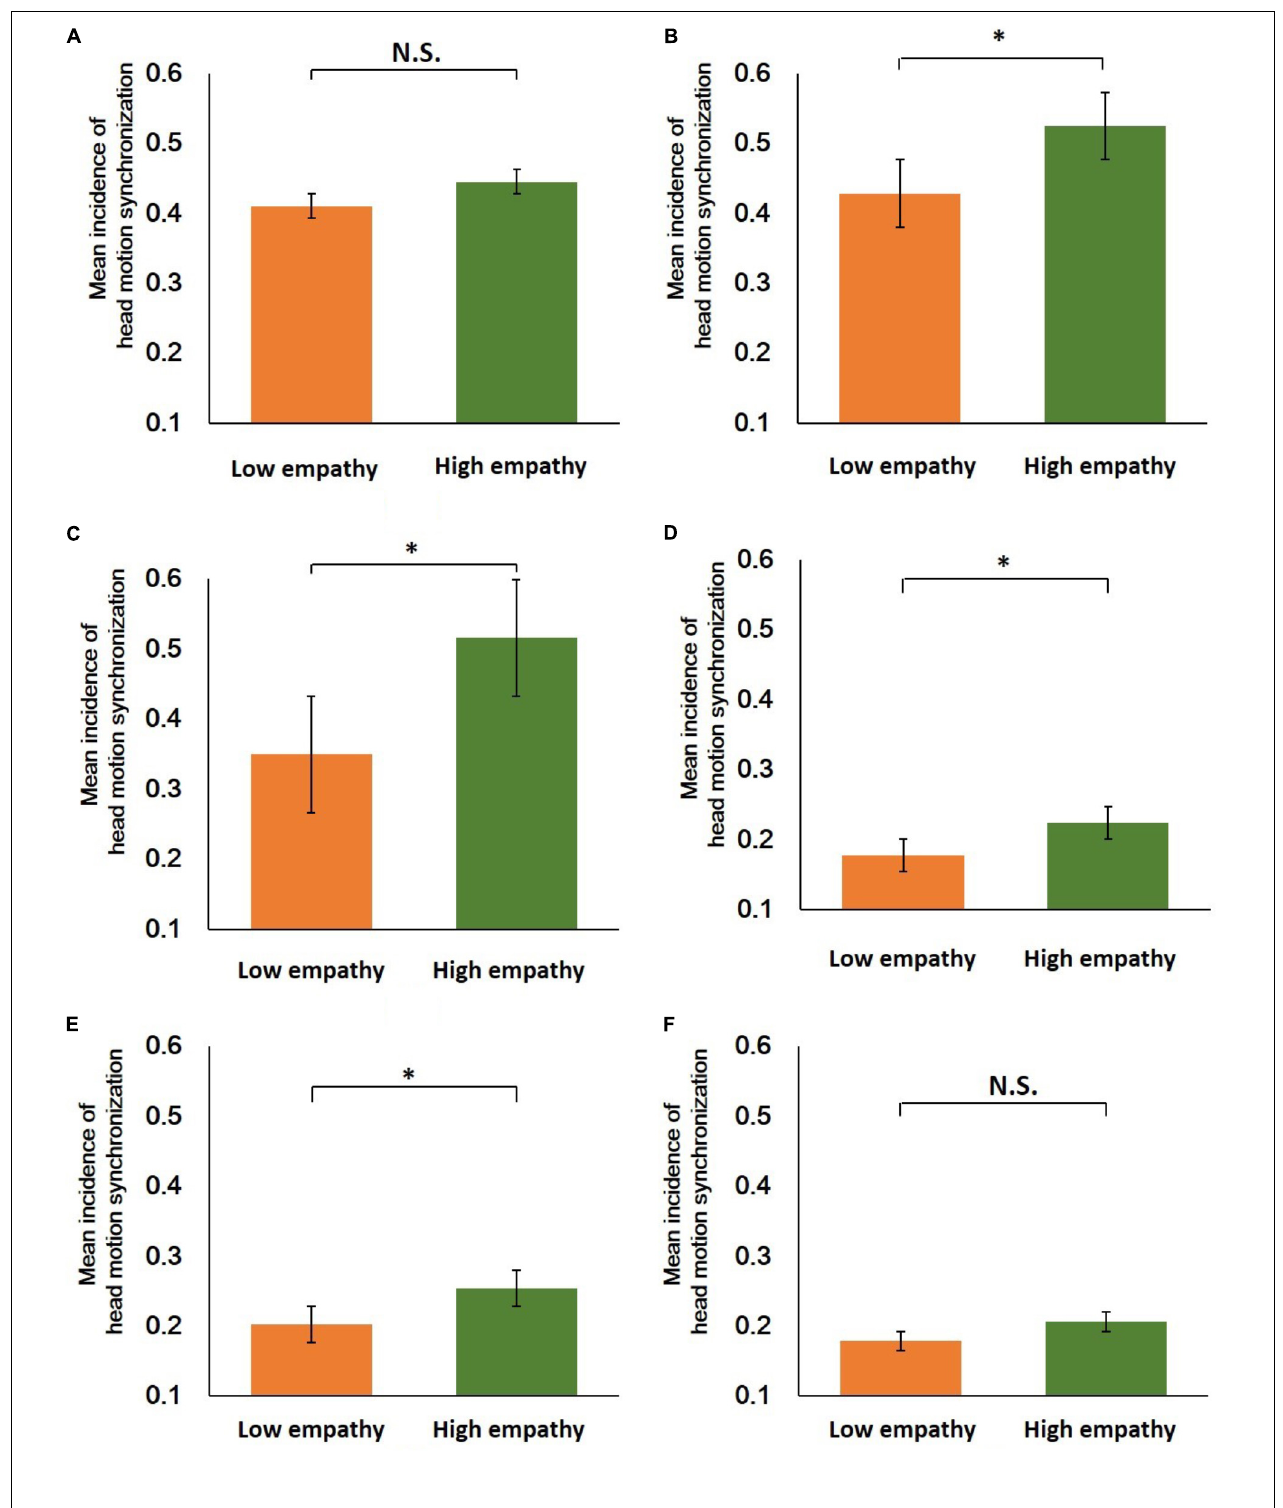
FIGURE 7 | Wilcoxon’s signed rank test for low and high empathy conditions for each area in Figure 6 . (A) Area a ( n = 23, Z = –1.73, N.S.). (B) Area b ( n = 23, Z = –3.32, ∗ p < 0.01). (C) Area c ( n = 23, Z = –3.38, ∗ p < 0.01). (D) Area d ( n = 23, Z = − 3.32, ∗ p < 0.01). (E) Area e ( n = 23, Z = –3.15, ∗ p < 0.01). (F) Area f ( n = 23, Z = –2.47,